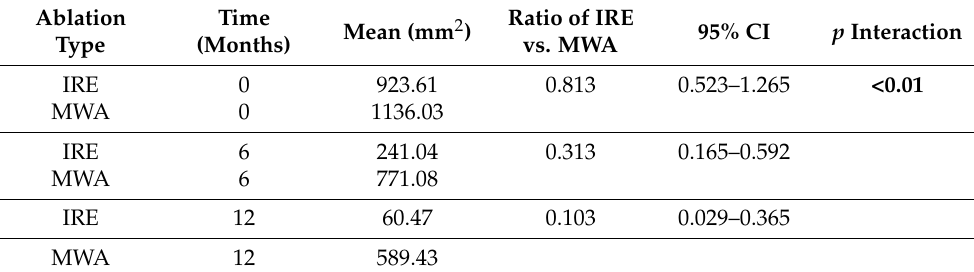
Table 2. Effect of treatment on surface area at each time